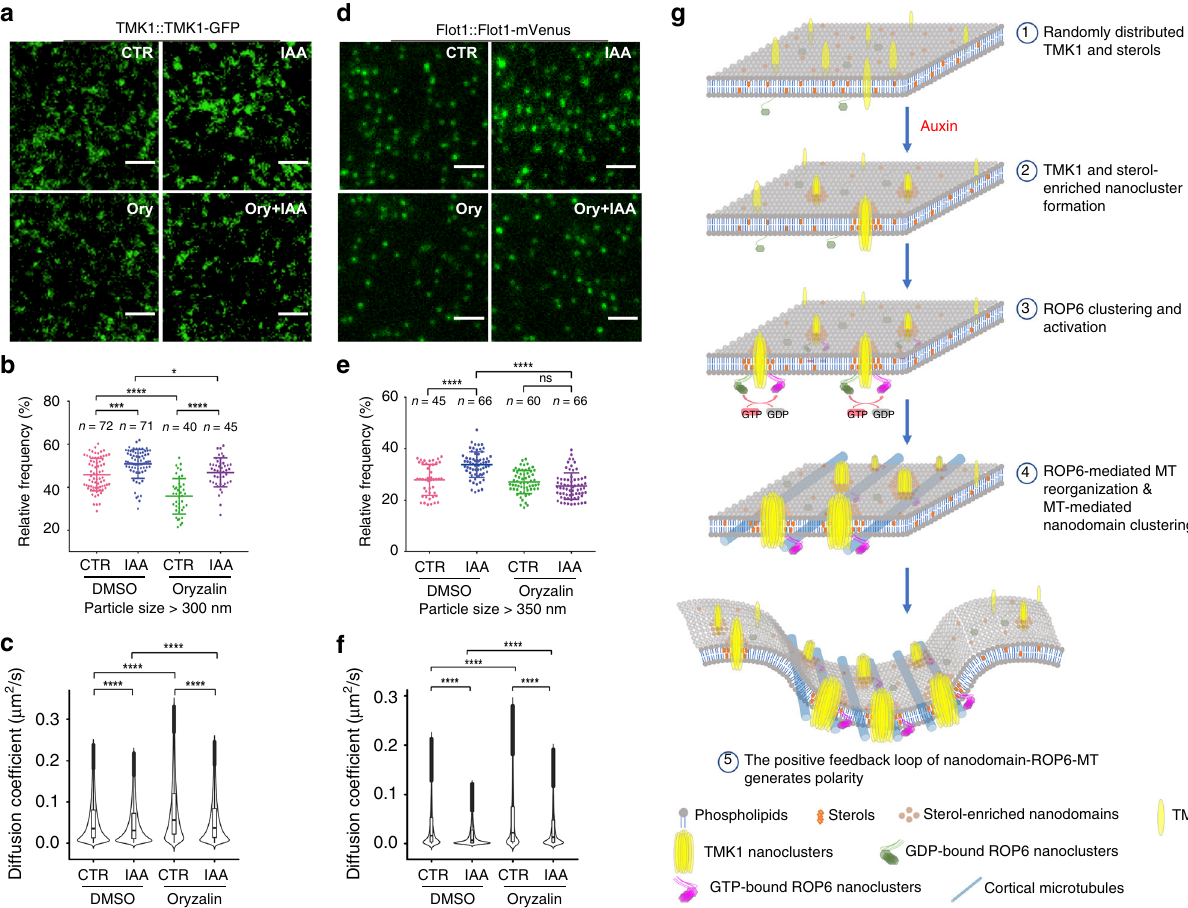
Fig. 6 Cortical microtubules stabilize TMK1 and fl otillin1 nanoclusters at the plasma membrane. a – c Auxin-induced dynamic changes of TMK1 particles were not fully compromised by microtubule disruption. a Representative TIRF images of pavement cells (PCs) expressing TMK1::TMK1-GFP with or without IAA (100 nM, 10 min) and oryzalin (5 µ M, 30 min) treatments. b Relative frequency of TMK1 particles with size larger than 300 nm. c Comparison of diffusion coef fi cients of TMK1 particles in different treatments. The number of particles analyzed in each treatment (from left to right) are 156,480, 131,187, 85,436, and 96,457, respectively. Note: The oryzalin and m β CD treatments (Fig. 3) on TMK1 dynamics were performed in the same batch, and the same mock treatment was used. The data and representative images for the control group are the same for Fig. 3b – f and a – c . d – f Auxin-induced dynamic changes of fl otillin1(Flot1) particles were not completely compromised by microtubule disruption. d Representative TIRF images of PCs expressing fl otillin1:: fl otillin1-mVenus with or without IAA (100 nM, 10 min) and oryzalin (5 µ M, 30 min) treatments. e Relative frequency of fl otillin1 particles with size larger than 350 nm. f Comparison of diffusion coef fi cients of fl otillin1 particles in different treatments. The number of particles analyzed in each treatment (from left to right) are 36,937, 47,316, 53,899, and 50,214, respectively. CTR, control. g Schematic illustration showing the steps involved in the